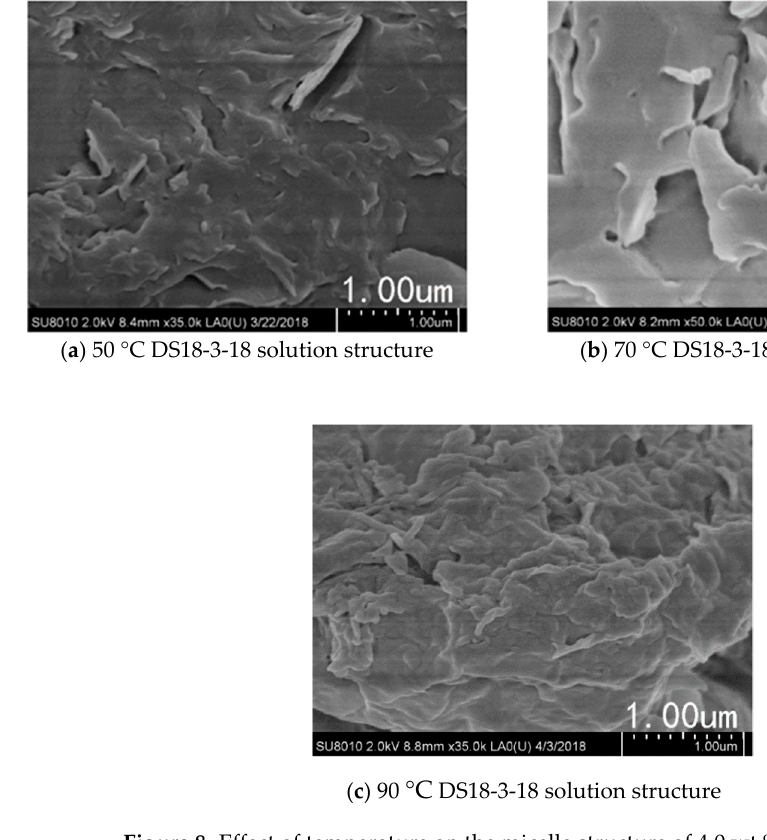
Figure 8. Effect of temperature on the micelle structure of 4.0 wt.% DS18-3-18.